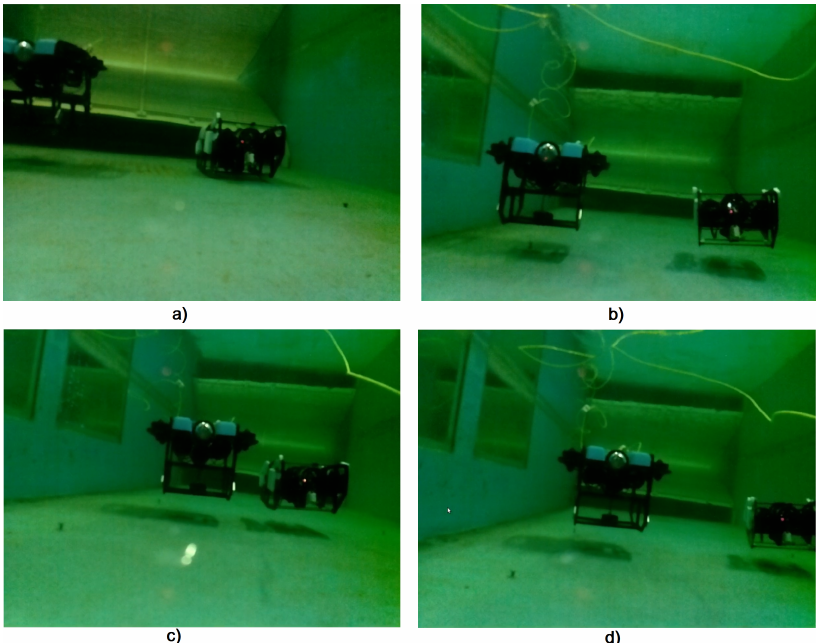
Figure 18. Image of the two following robots as seen from the camera of the leading robot. ( a ) descrip- tion of the initial position of the robots follower. ( b – d ) illustration of the movement of the follower robots to make the